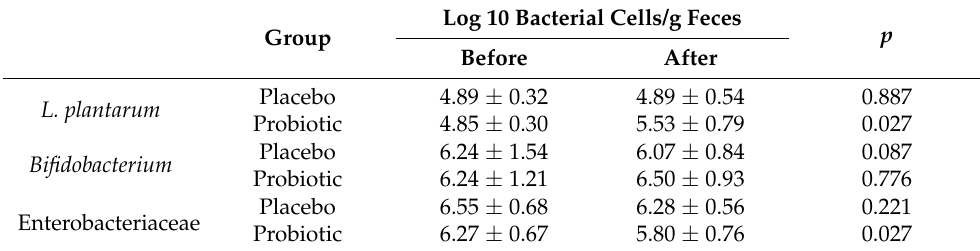
Table 6. The number of specific bacteria analyzed by